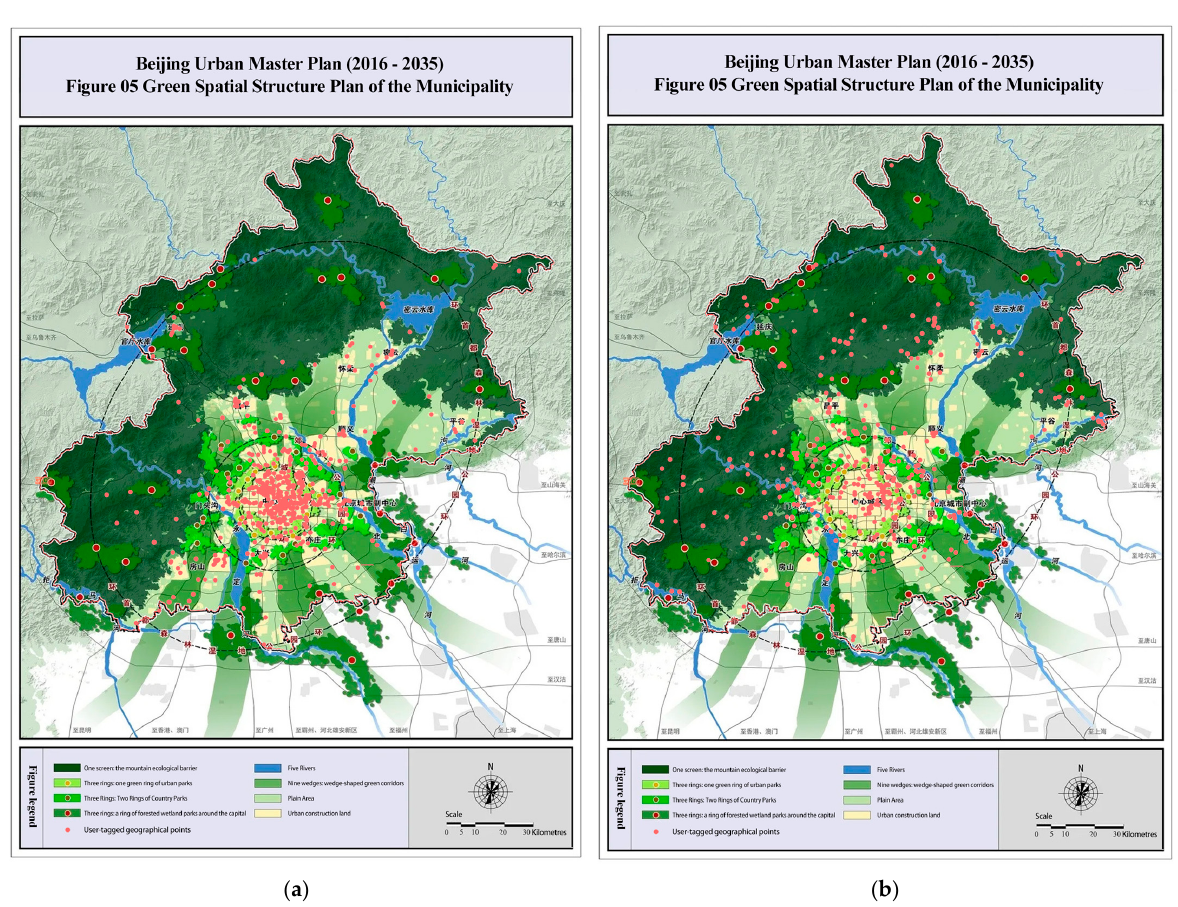
Figure 13. ( a ) Coupling of user geographic markers and planning maps (before the outbreak); ( b ) coupling of user geographic markers and planning maps (during the outbreak).